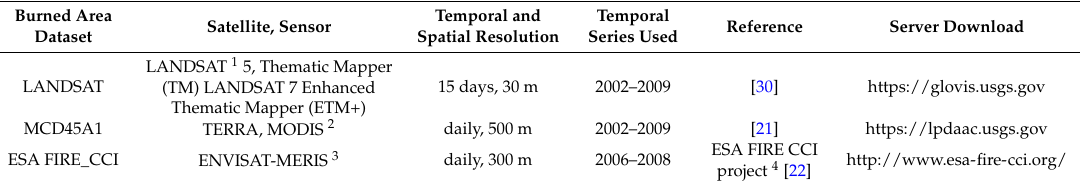
Table 1. Descriptions of global burned area data used in detecting fire